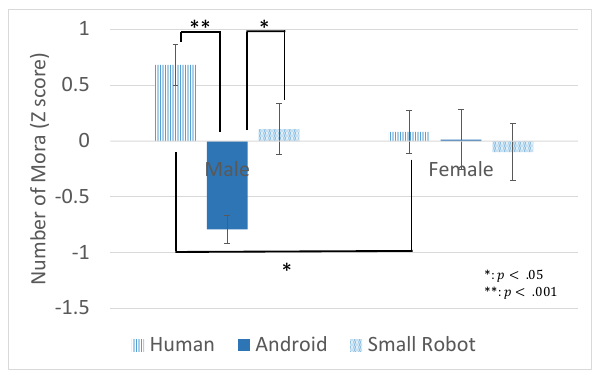
Figure 7. Amount of self-disclosure (The error bars show the standard